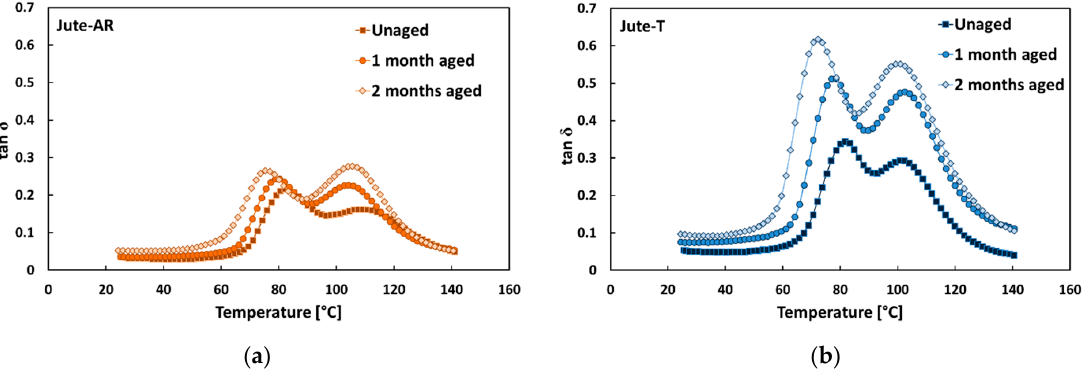
Figure 5. Typical tan δ trends of jute composites in each aging condition: ( a ) Jute-AR composites; ( b ) Jute-T composites.